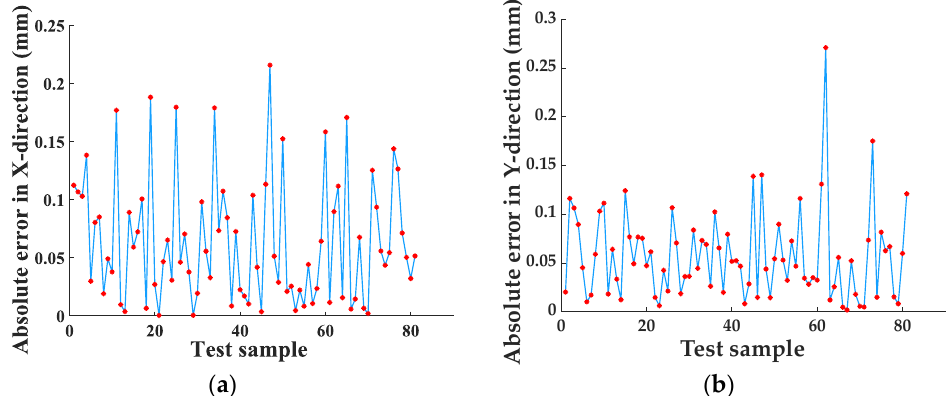
Figure 12. Final test results, ( a ) absolute error in X-direction, ( b ) absolute error in Y-direction.